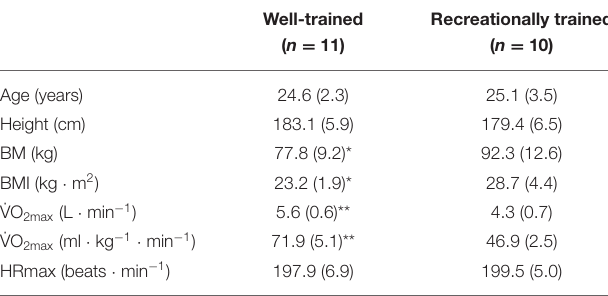
TABLE 1 | Participant characteristics.